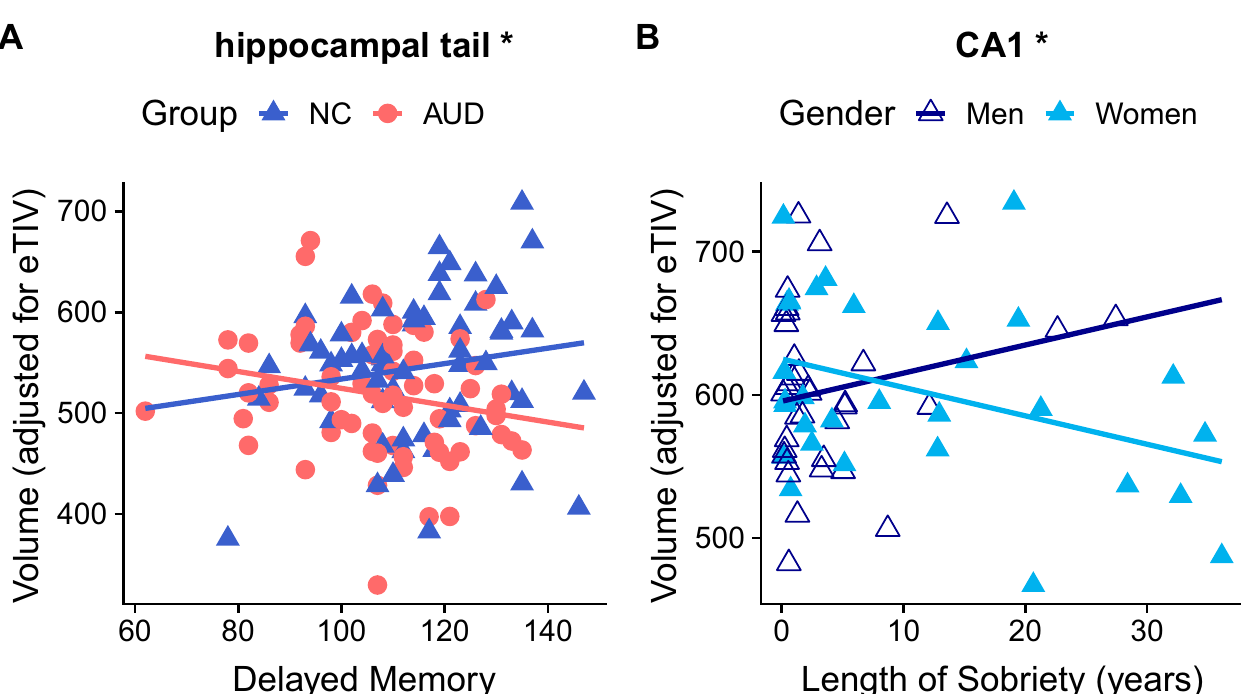
Fig 3. Significant interactions for group-by-region-by-DMI and gender-by-region-by-LOS. A. For the AUD group, Delayed Memory was associated with lower hippocampal tail volumes, while for the NC group, a positive relationship was observed. B. For AUD men, CA1 volumes (adjusted for eTIV) were positively associated with Length of Sobriety (years), while for AUD women, a negative relationship was observed. Abbreviations: DMI = Delayed Memory Index; LOS = Length of Sobriety; CA1 = cornu ammonis 1; NC = Nonalcoholic Control group; AUD = Group with history of Alcohol Use Disorder; eTIV = estimated total intracranial volume. � Indicates regions with interactions significant at p < 0.0042.